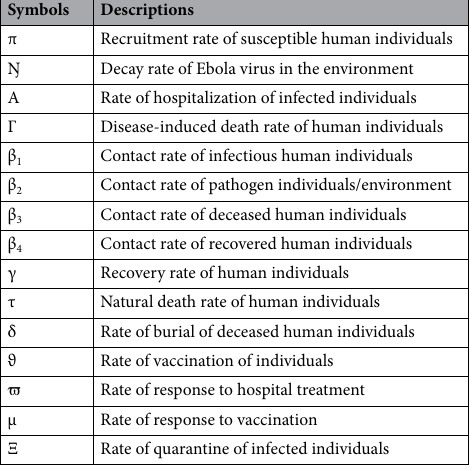
Table 1. A description of notation and coefficients used in Eqs.